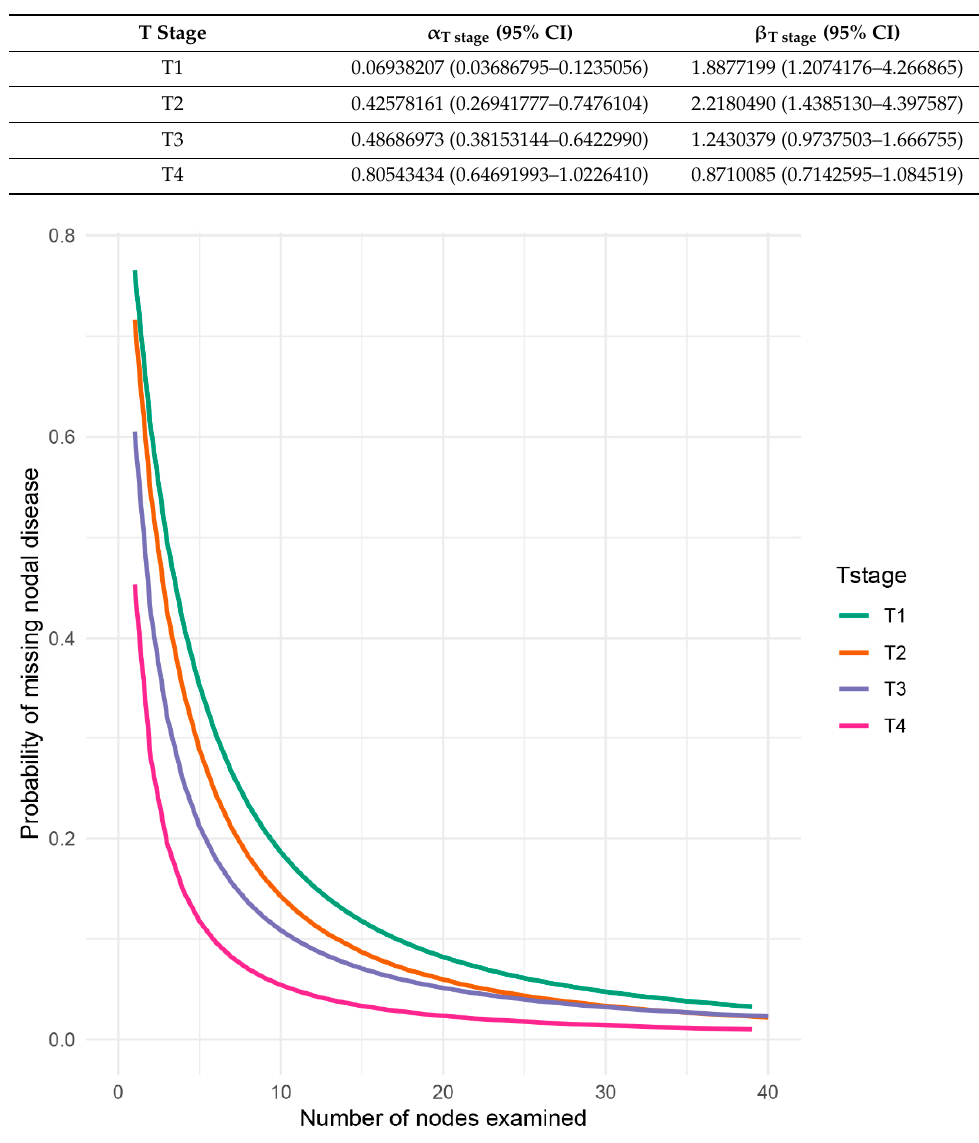
Table 2. α T stage β T stage parameters determined by fitness of β -binomial model. CI: confidential interval.